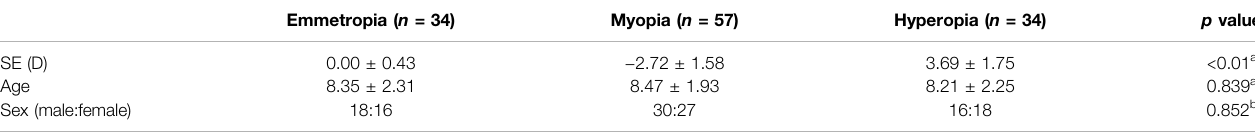
TABLE 1 | Subject demographics of emmetropic, myopic and hyperopic